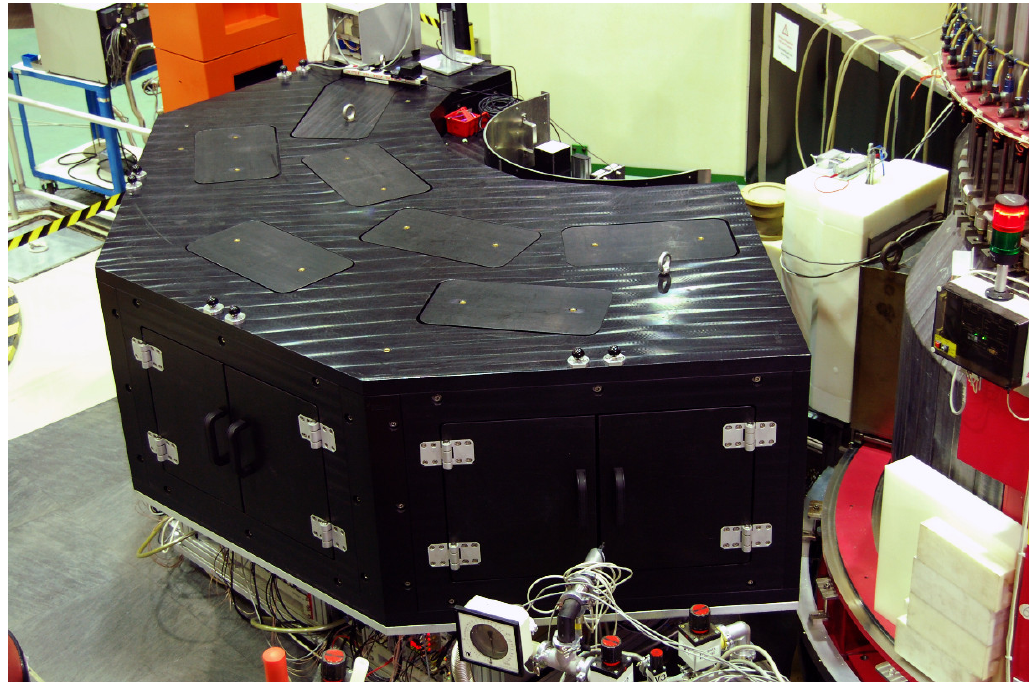
Figure 1: View of